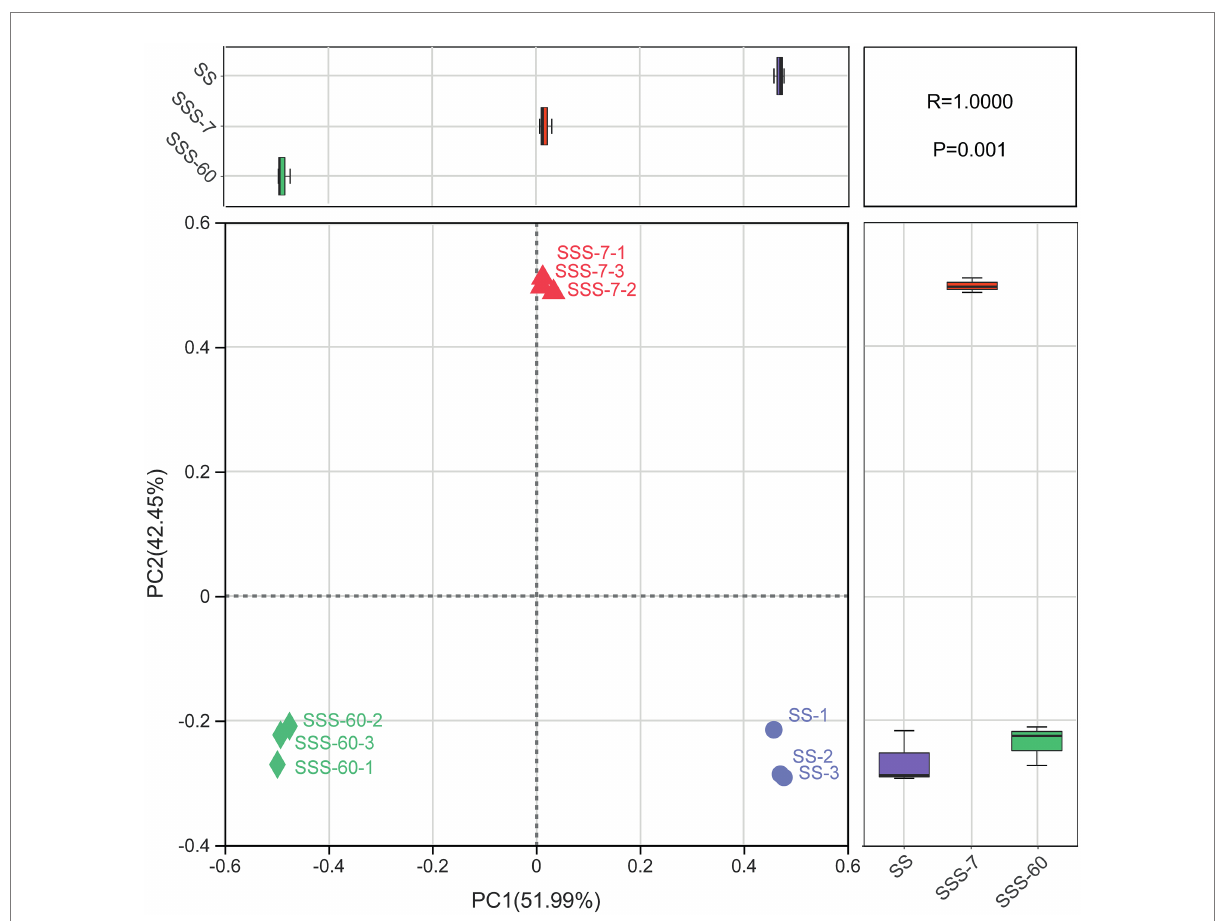
FIGURE 2 Bacterial β -diversity of fresh and ensiled EG, calculated by principal co-ordinates analysis (PCoA) plot based on the Bray–Curtis distance metric. SS, high-moisture sweet sorghum; SSS, SS